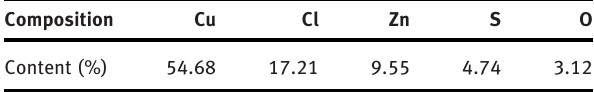
Table 1: The thermal decomposition and synthesis of Cu 2 OCl 2. Temperature Reaction About 